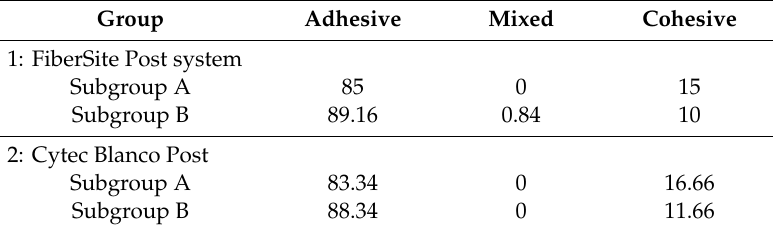
Table 3. Failure mode (%) for each